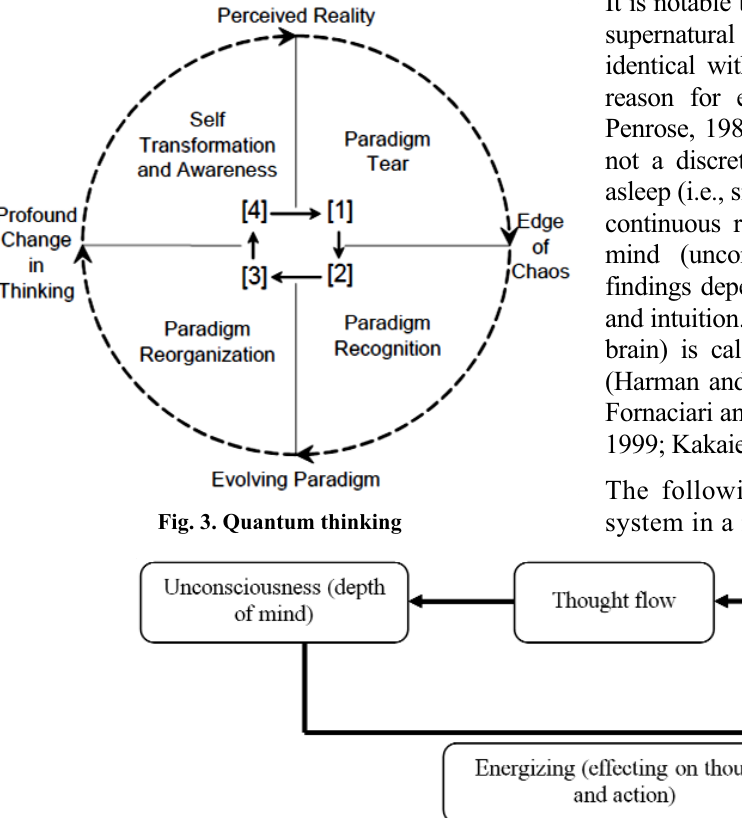
Fig. 3. The brain meta-algorithmic